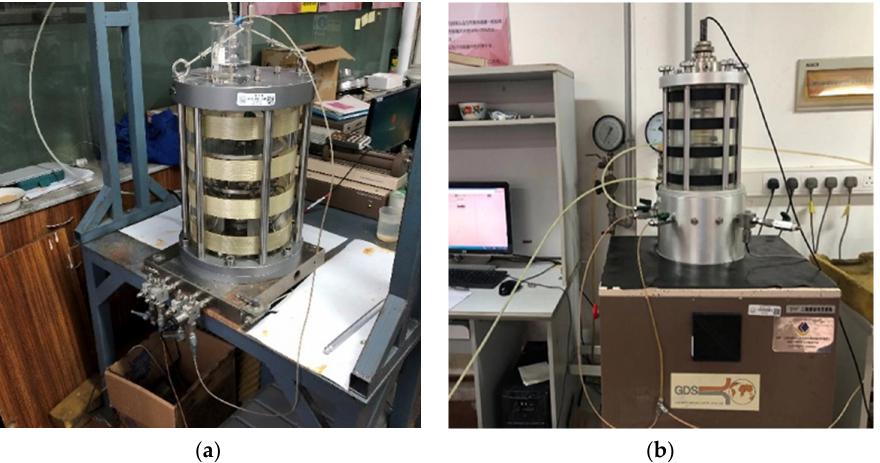
Figure 2. The apparatus used in this test: ( a ) GDS resonant column device; ( b ) GDS cycle triaxial device.